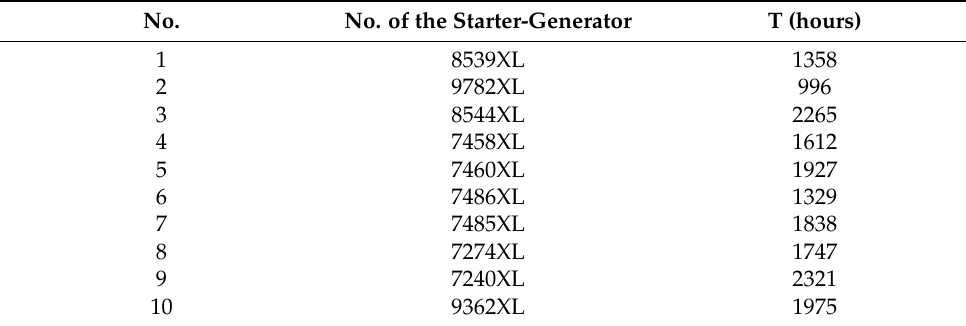
Figure 12. Characteristics of the reliability function R(t) of brushes in the 200SGL129Q starter-generators. Table 2. Calculation results of total durability for 10 starter-generators.